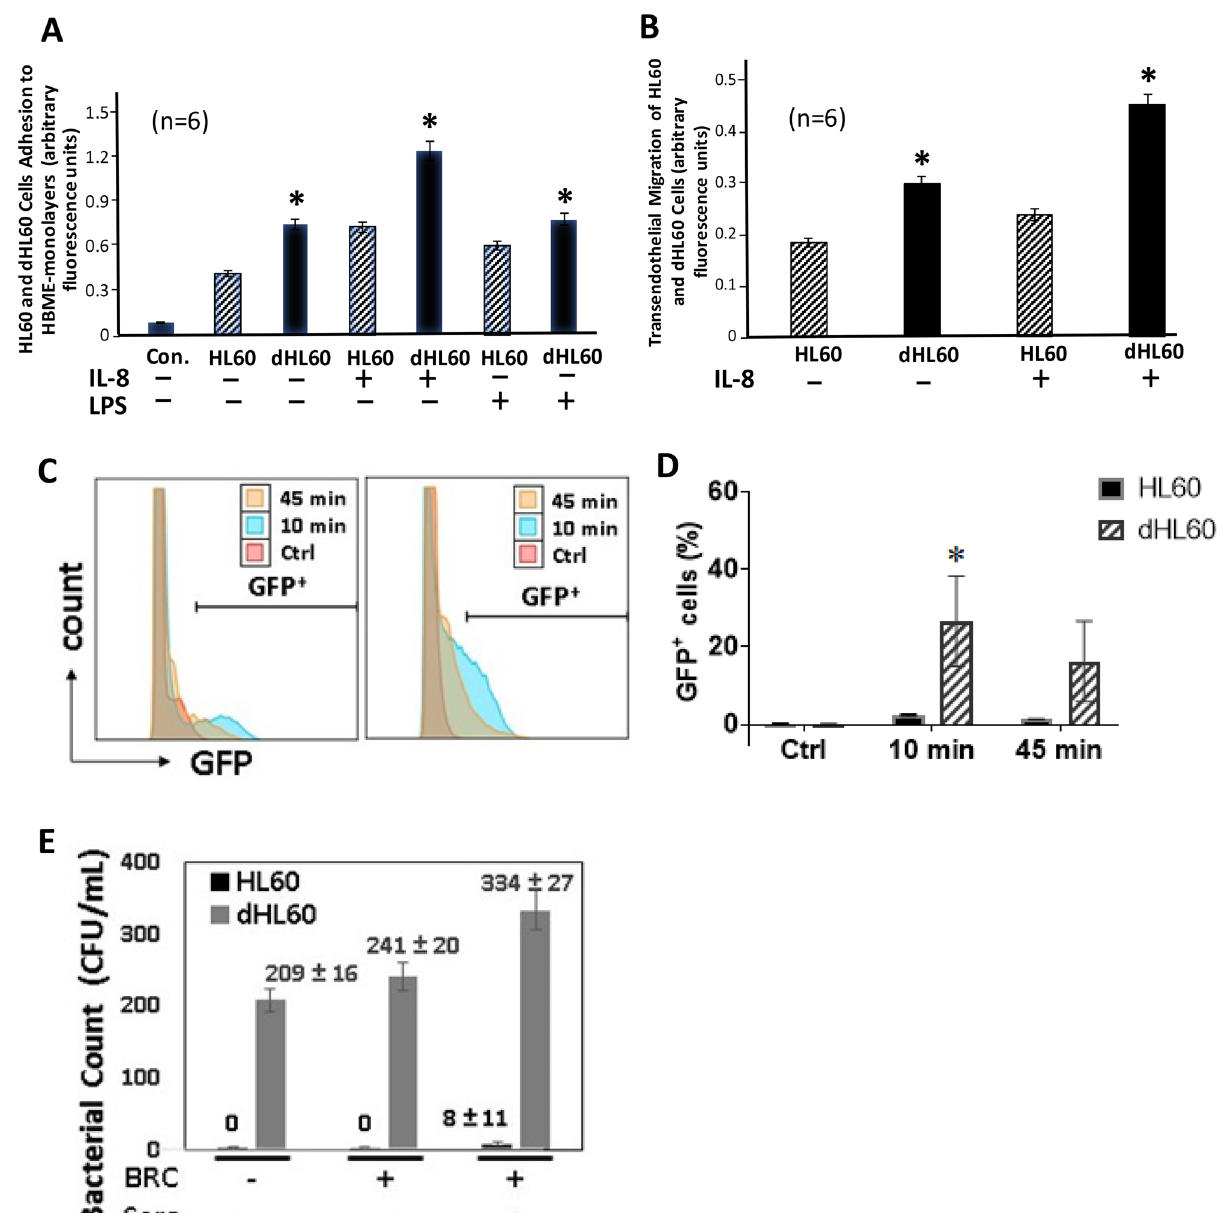
Figure 10. Cell Adhesion to and Migration across HBME Monolayers and Phagocytosis of GFP-Expressing P. aeruginosa ( A ) HMBEs were cultured to postconfluence in 24-well plates. The HBME monolayers were pretreated for 4 h with LPS 200 ng/ml or medium alone and gently washed. Equivalent concentrations of calcein AM-labeled HL60 and dHL60 cells, after pretreatment for 2 h with IL-8 3 nM or medium alone, were washed and co-incubated for 0.5 h with HBME monolayers. After gentle washing to remove nonadherent cells, the attached cells were fluorometrically assayed (excitation 485 nm, emission 530 nm) in a fluorescence plate reader. ( B ) HBMEs were cultured to postconfluence on the filter supports of transwell chambers. Equivalent concentrations of viable calcein AM-labeled HL60 and dHL60 cells were introduced into the upper compartment whereas IL-8 or medium alone was placed in the lower compartment and the transwell chambers incubated for 2 h at 37 °C. After incubation for 2 h, each compartment of each chamber was sampled and labeled cells fluorometrically assayed. Vertical bars represent mean ± SE adhesion/migration. ( C , D ). The nondifferentiated and DMF-differentiated HL60 cells were mixed with PAK-GFP at a MOI of 25, incubated for 10 or 45 min, and fixed for flow cytometric analysis. The cells alone served as negative control (Ctrl). The histograms ( C ) and the percentage of GFP-positive cells ( D ) are shown. ( E ) Non-opsonized (BRC − /sera − ) and BBRC − -and BRC + sera + -opsonized P. aeruginosa were mixed with either nondifferentiated or DMF- differentiated HL60 cells, incubated at 37 °C for 45 min, and the mixtures sampled for CFUs. *, significantly increased adhesion, migration, or opsonophagocytosis in dHL60 cells compared with that seen for HL60 cells at p < 0.05. The data generated in each panel represents experiments performed on ≥ 2 independent